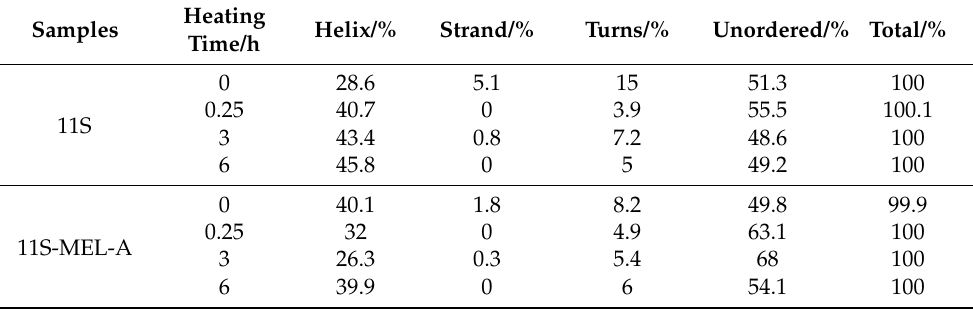
Figure 4. Effect of MEL-A on the secondary structure of 11S protein upon heating treatment. ( A ) CD spectra of 11S in the absence and presence of MEL-A at different concentrations ranging from 0 to 5.0 mg/mL. ( B ) CD spectra of 11S and 11S-MEL-A after heating treatment ranged from 0 to 6.0 h. The changes in the secondary structures are summarized in charts. ( C ) Effects of different MEL-A concentrations (0, 0.01, 0.25, 0.5, 2.5, and 5.0 mg/mL) on the fluorescence intensity of 11S. The inset presents the Stern–Volmer plots describing the fluorescence quenching of 11S in the presence of MEL-A. ( D ) The fluorescence intensity changes of 11S with the addition of 0.5 mg/mL MEL-A (above CMC) after heat treatment. Table 1. Prediction values of protein secondary structure upon different heating